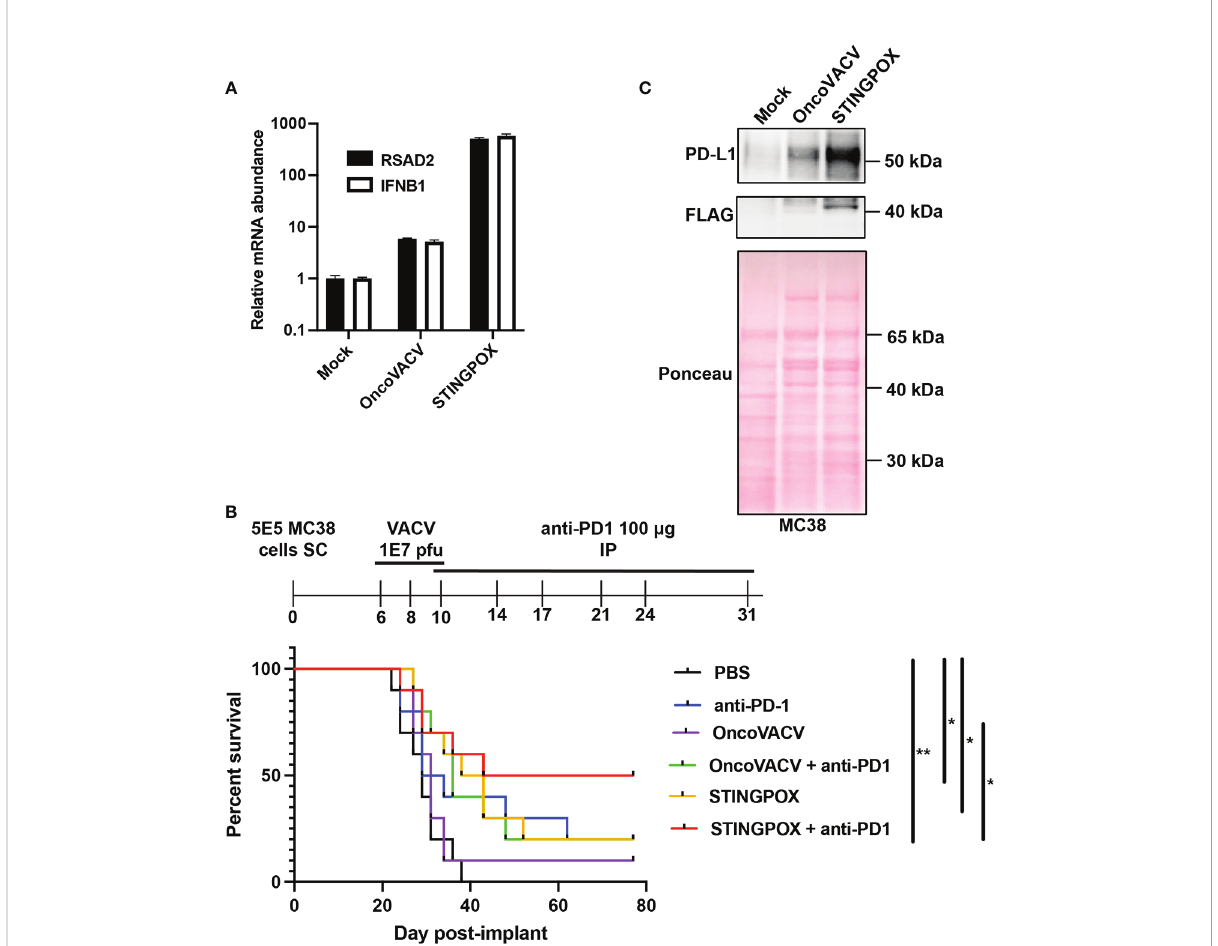
FIGURE 5 STINGPOX induces anti-tumor effects in vivo . (A) Ovarian tumor explants were infected with STINGPOX or OncoVACV (1E4 PFU per tumor core), and qRT-PCR analysis was performed 72 hours post-infection to measure relative RSAD2 (n=3) and IFNB1 (n ≥ 2) expression levels. (B) Mice bearing subcutaneous (SC) MC38 colorectal tumor, were treated with 3 doses intratumorally of PBS, OncoVACV, or STINGPOX intratumorally (IT) and anti-PD1 intraperitoneally (IP) as indicated in the timeline. Mouse survival plots are shown. (n=10 per group; *p<0.05; **p<0.005). (C) MC38 cells were infected in vitro with OncoVACV-GFP and STINGPOX (MOI = 1), and 48 hours post-infection, whole cell lysates were analyzed by WB for PD-L1 and disA (FLAG) expression. Ponceau staining of blot is shown for loading control. Data are shown as mean ±